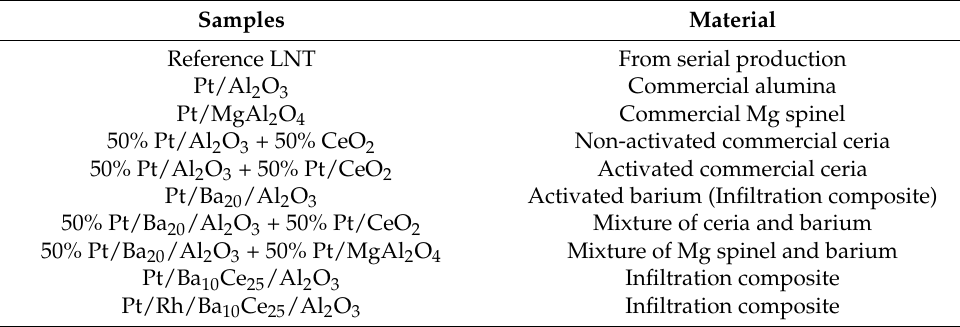
Table 2. Investigated NO X storage